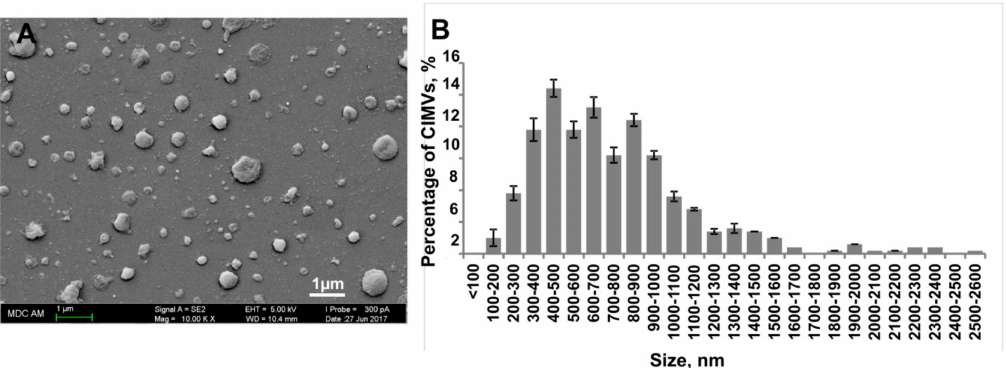
Figure 2. Analysis of the morphology and the size distribution of human cytochalasin B-induced membrane vesicles (CIMVs)-MSCs. Human CIMVs-MSCs were characterized using scanning electron microscopy ( A ). At least six electron microscope images were analyzed from three independent experiments to determine the size of human CIMVs-MSCs ( B ).